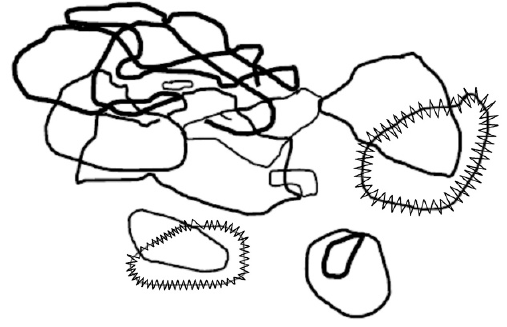
Figure 4 . The images of X R and X L are represented by the closed curves called cyclic chains. The all curves do not have